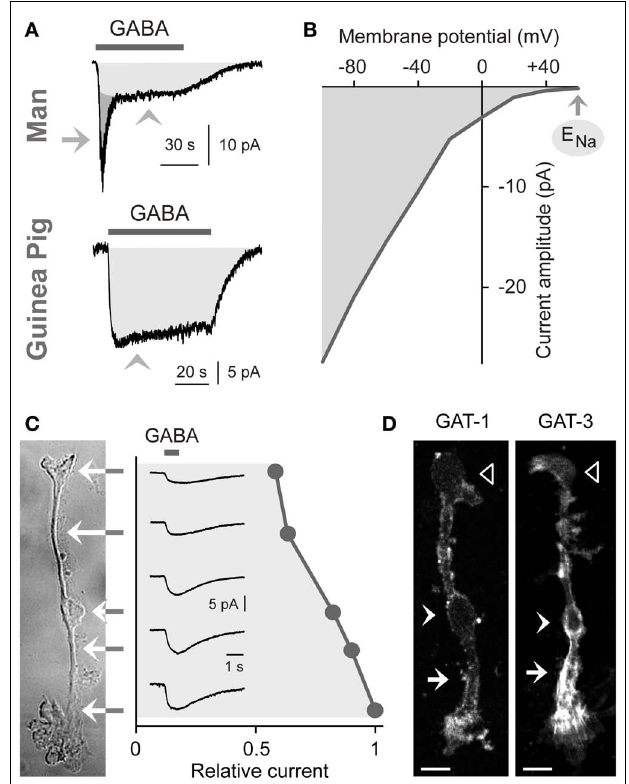
FIGURE 2 | Electrogenic GABA transport in Müller cells. The GABA-evoked membrane currents were recorded in freshly isolated Müller cells from man (A) and guinea pigs (A–C) . (A) Extracellular administration of GABA (100 µ M) evokes two kinds of inward currents in a human Müller cell: a transient, rapidly inactivating chloride current mediated by GABA A receptors ( arrow ) and a sustained current mediated by electrogenic GABA transporters ( arrowhead ). In guinea pig Müller cells (which lack GABA A receptors), extracellular GABA (1mM) evokes only a transporter-mediated inward current.The holding potential was − 80mV. (B) Current-voltage relation of the GABA transporter currents in guinea pig Müller cells.The amplitude of the transporter currents is zero near the equilibrium potential of sodium ions (E Na ) (when recorded with symmetrical chloride concentration at both sides of the membrane). GABA was administered at a concentration of 100 µ M. (C) Subcellular distribution of the GABA transporter currents.The distribution of the currents was determined by focal ejections of GABA (1mM) onto the following membrane domains of Müller cells: endfoot, inner stem process, soma, inner and outer parts of the outer stem process. (D) Distribution of GAT-1 and GAT-3 immunoreactivities in isolated Müller cells of the guinea pig. Filled arrows , outer stem process. Filled arrowheads , cell soma. Unfilled arrowheads , cell endfoot. Bars, 10 µ m.With permission from Biedermann et al. (2002, 2004).